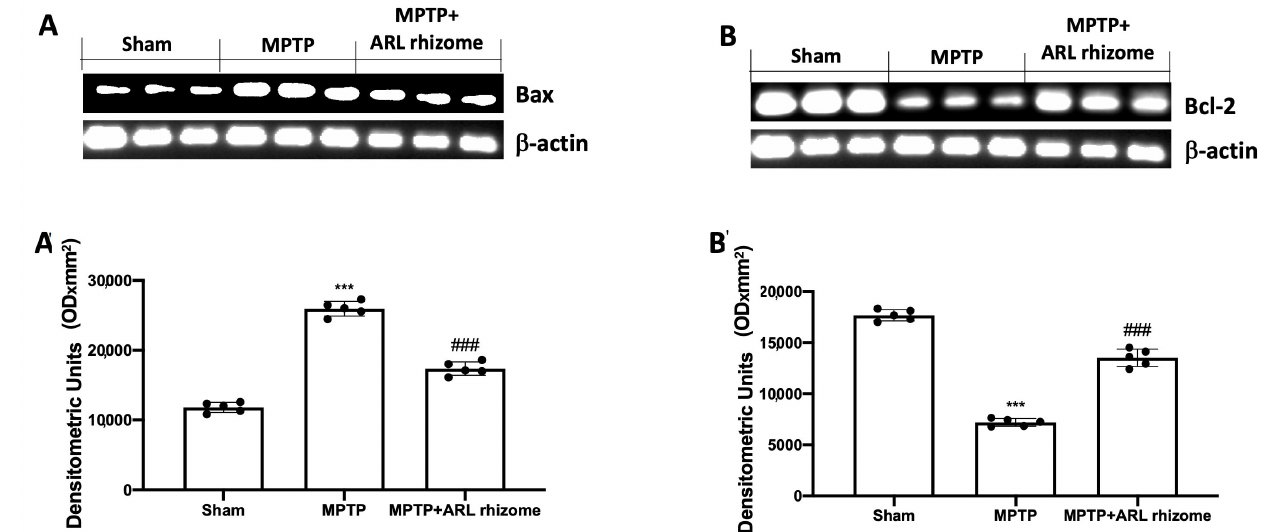
Figure 3. Effect of ARL rhizome on Bax and Bcl-2 expression after MPTP-injection. Western blots for Bax ( A , A’ ) and Bcl-2 ( B , B’ ) expression were performed. A demonstrative blot of lysates (five animals/group), with a densitometric analysis for all animals, is shown ( A’ , B’ ). Values = means ± SD of five animals in each group. *** p < 0.001 vs. Sham; ### p < 0.001 vs. MPTP.